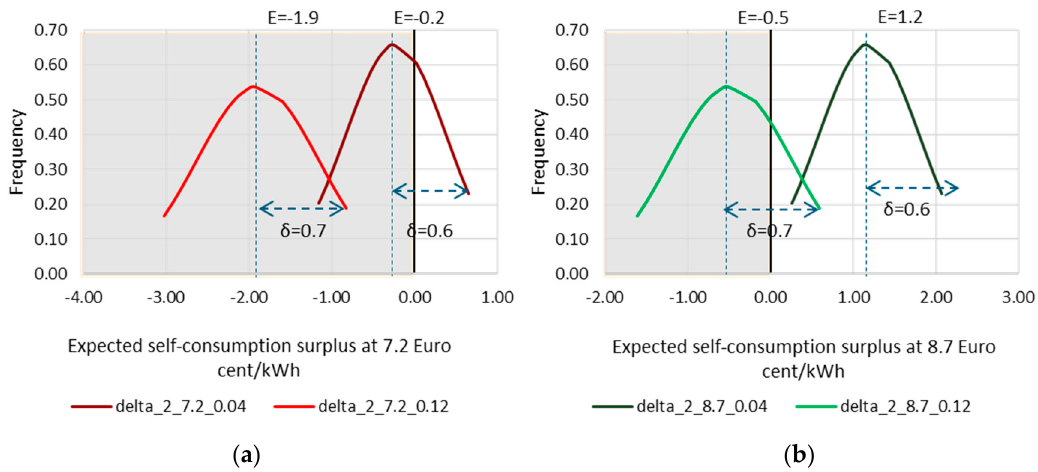
Figure 14. Competitive prices change in accordance with the projected grid tariff increases from ( a ) 7.2 to ( b ) 8.7 Euro cent/kWh.